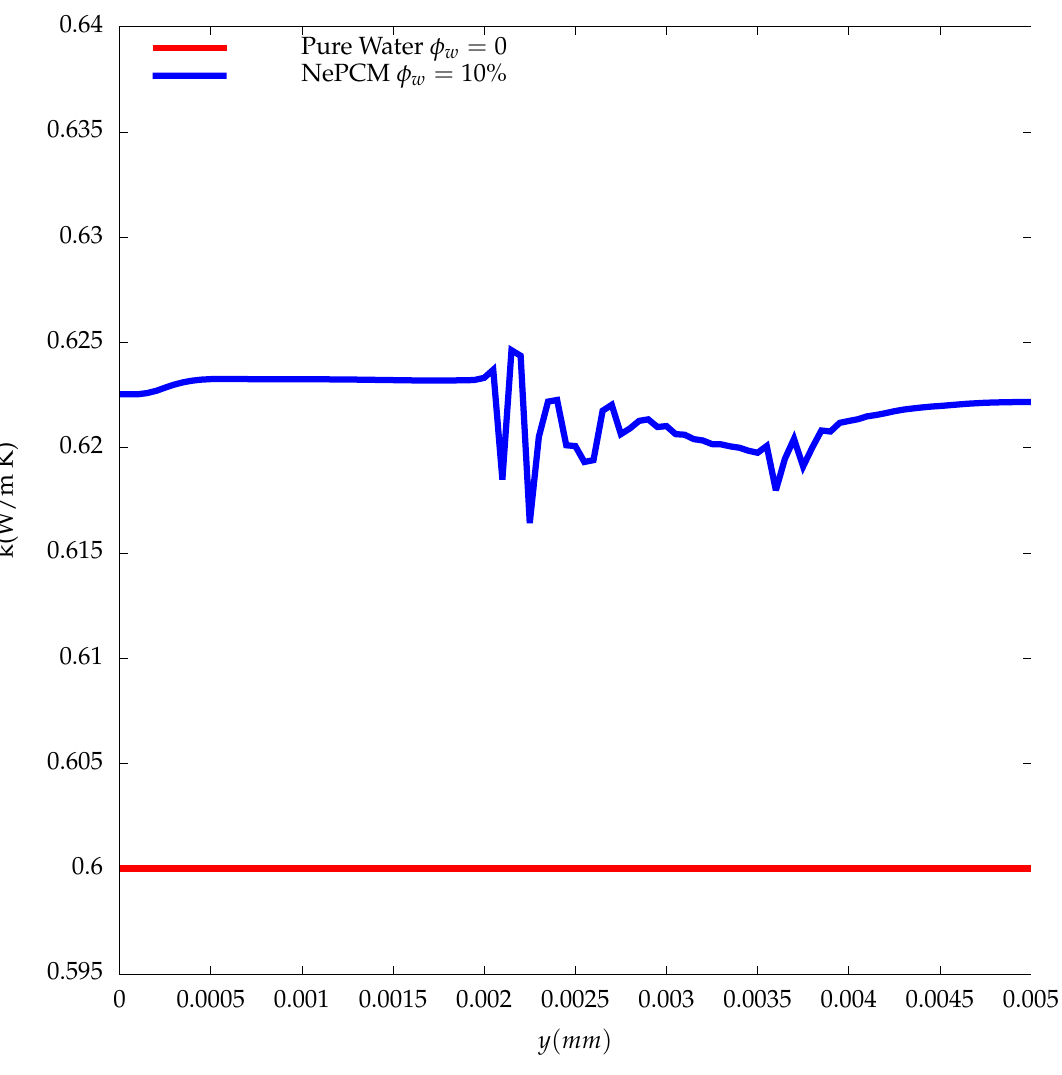
Figure 11. Compression between the thermal conductivity evolution along vertical line located at x = 0.005 mm, and a long the y -axis for the case of φ w = 0, and